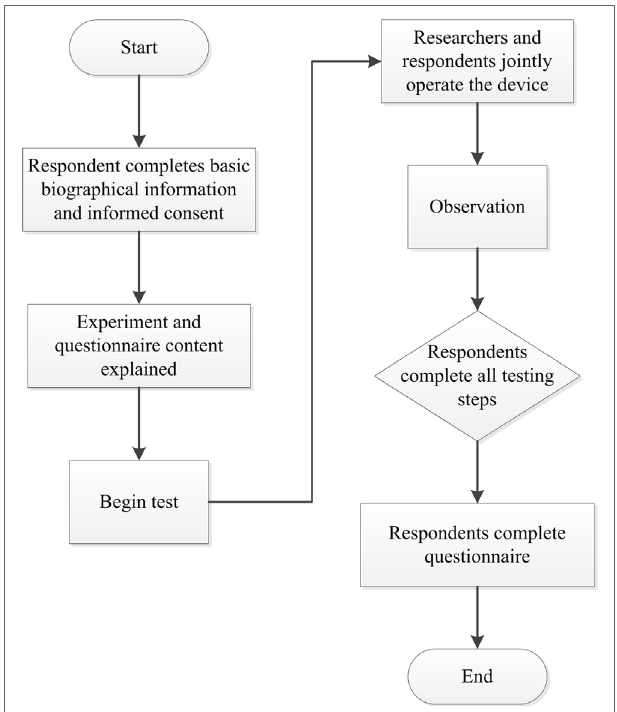
FigUre 1 | The flow of a usability